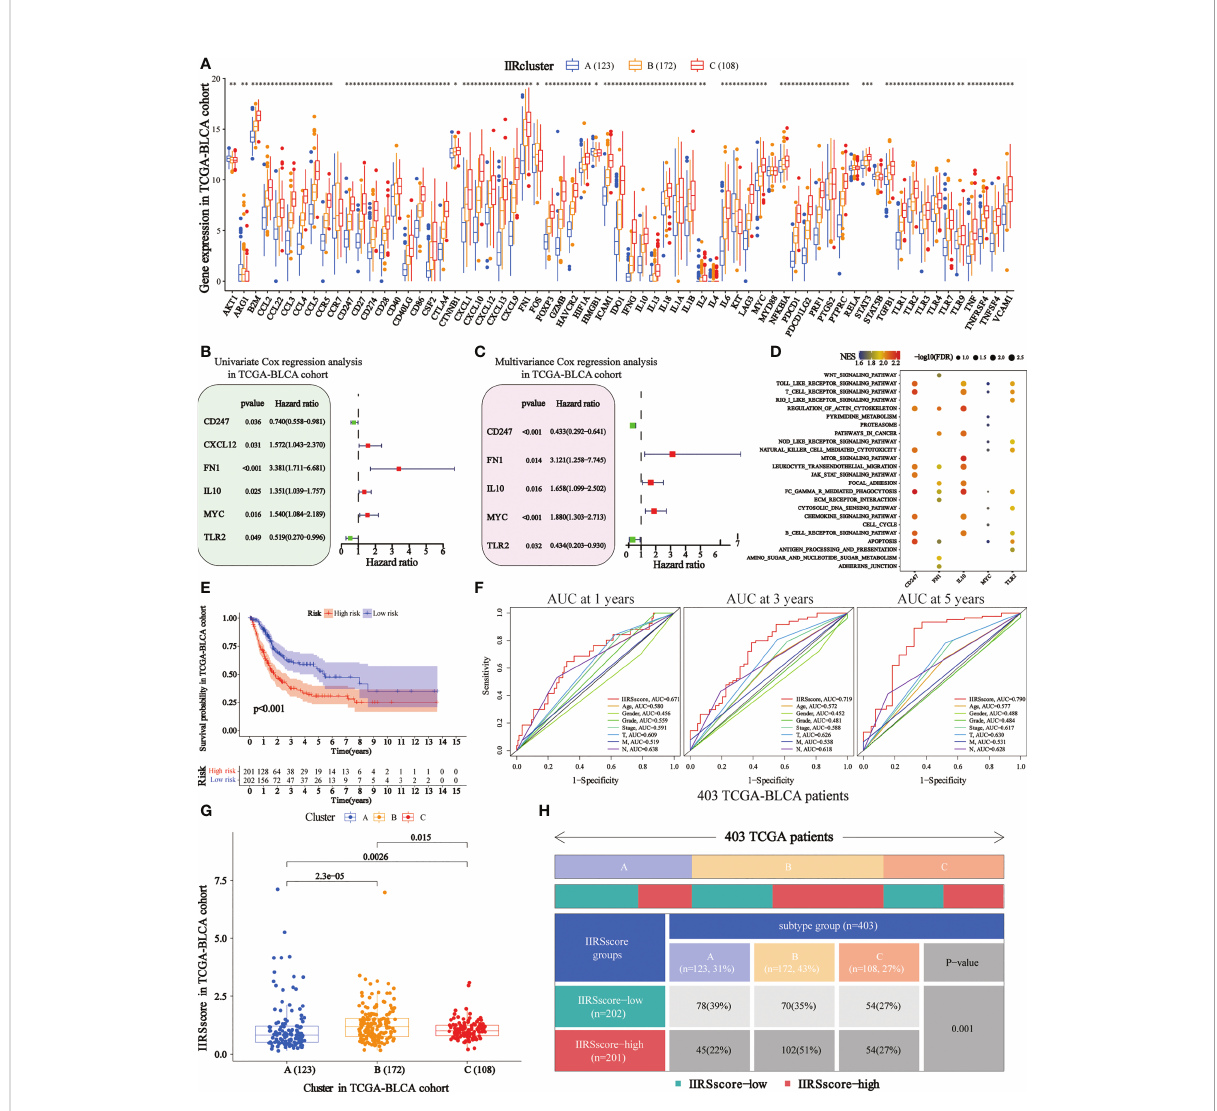
FIGURE 4 Construction of immune and in fl ammatory phenotype-related gene signature in TCGA-BLCA cohort. (A) Differences in the levels of the 85 IIRGs in three subtypes (***P< 0.001; **P< 0.01; *P< 0.05). (B, C) Forrest plot depicting the univariate and multivariance Cox regression analysis of DE. (D) Enrichment analysis for pathways in the high expression group of the IIRS genes. NES is the normalized enrichment score. (E) Survival analyses were applied to evaluate overall survival for the high- and low-risk groups in the TCGA train cohort. (F) AUCs (Area under ROC curve) for 1-, 3-, and 5-year OS and the risk score and clinical characteristics ROC curves. (G) Distributions of IIRS-score among clusters. (H) The Chi-square test was applied to evaluate the difference in immune and in fl ammatory patterns among patients in the high- and low-IIRS-score